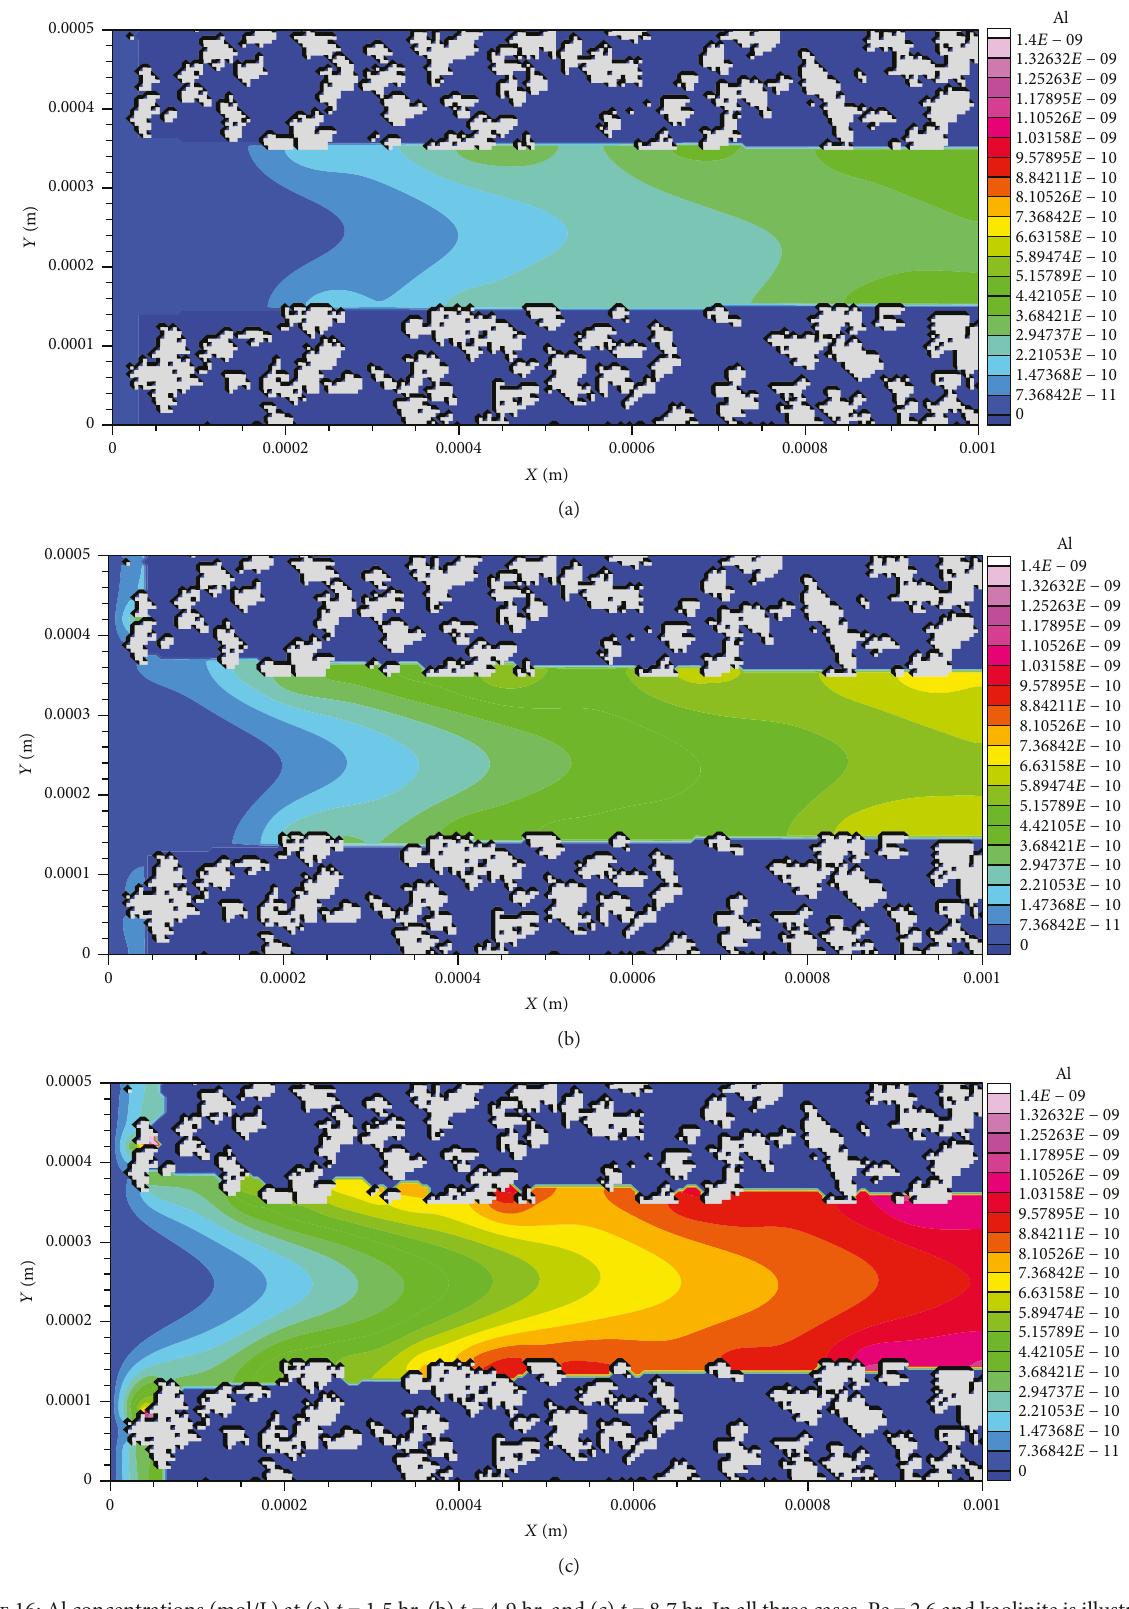
Figure 16: Al concentrations (mol/L) at (a) t = 1 5 hr, (b) t = 4 9 hr, and (c) t = 8 7 hr. In all three cases, Pe=2.6 and kaolinite is illustrated in light